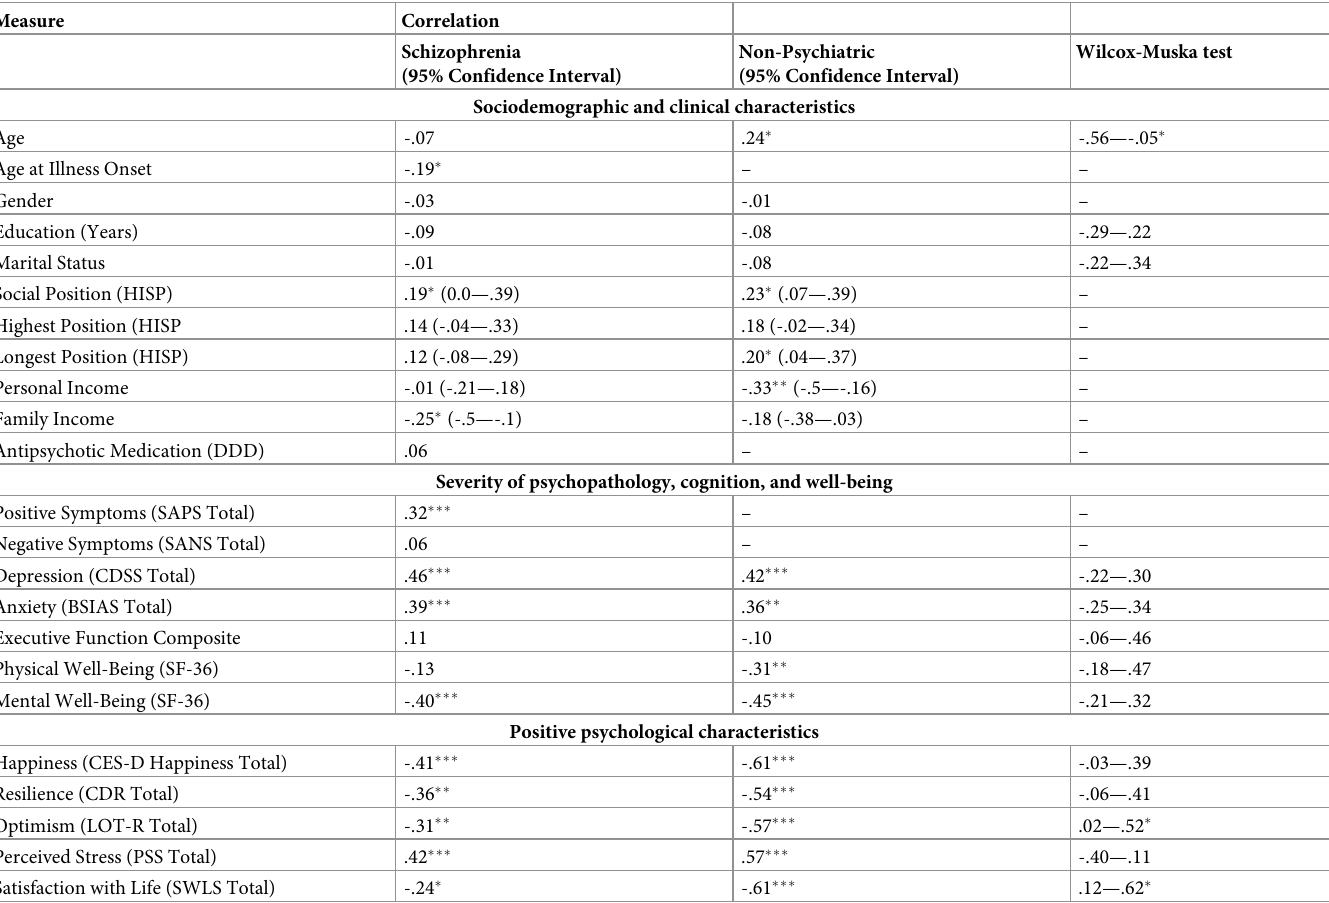
Table 5. Correlations between the UCLA-3 total score and important demographic, clinical, and positive psychological